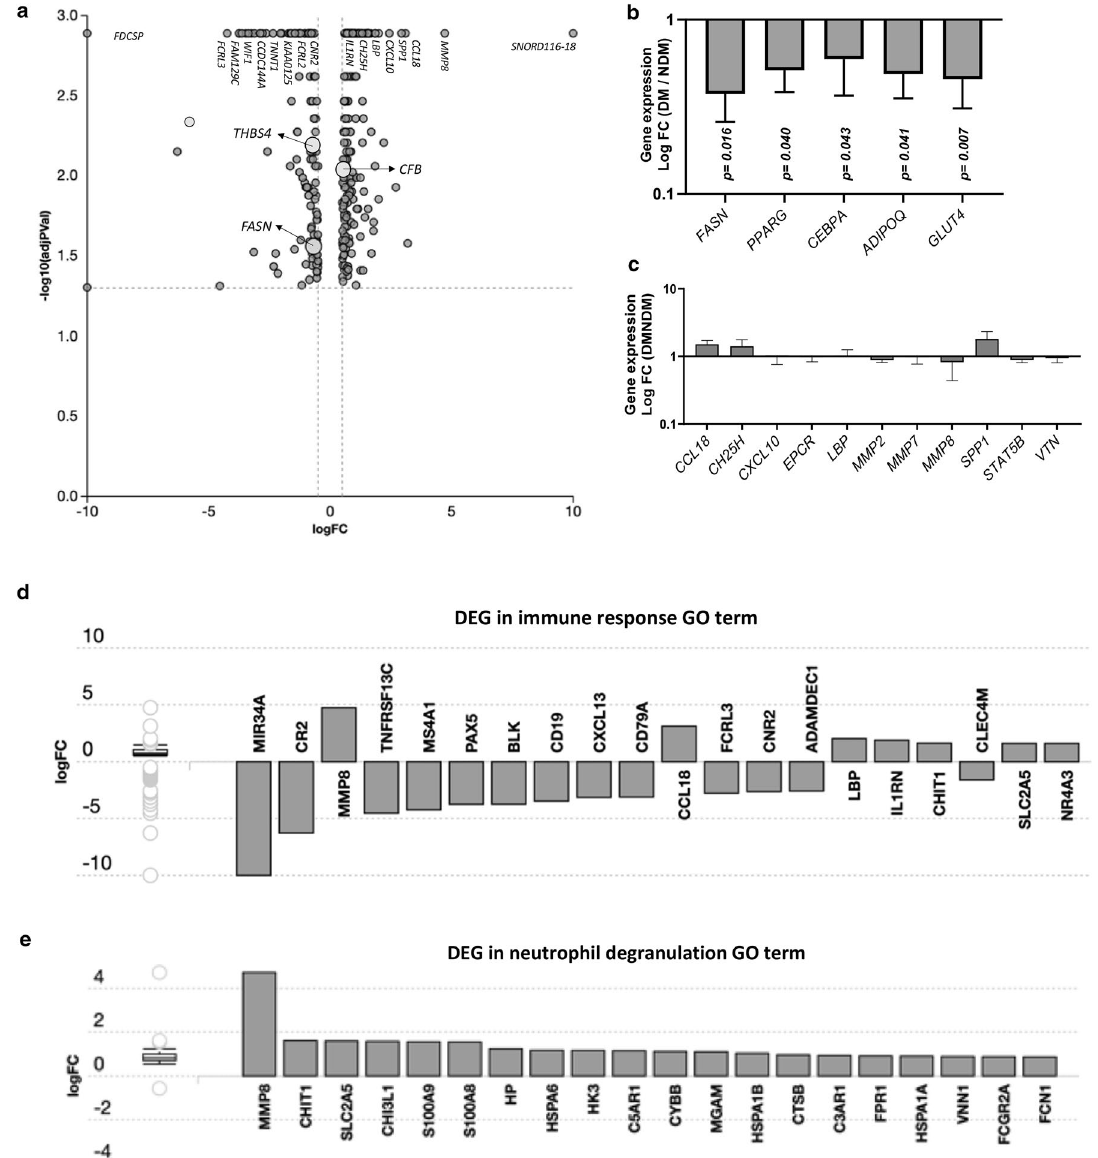
Figure 3. Differentially expressed genes and biological processes in DM and NDM VAT. ( a ) Volcano plot of gene expression in DM compared with NDM samples. All 372 significantly expressed genes (DEG) are represented in terms of their measured expression change (x-axis; log fold change) and the significance of the change (y-axis). The significance is represented as negative log (base 10) of the p-value, so that more significant genes are plotted higher on the y-axis. Genes represented on the left of logFC = 0 in the x-axis were downregulated in DM, and genes represented on the right were upregulated in DM. Dotted lines represent the thresholds used to select the DEG: 0.5 for expression change and 0.05 for significance. FASN, CFB and THBS-4 are highlighted in graph as molecules significantly regulated by DM at mRNA and protein levels. ( b ) qRT- PCR analysis of VAT for FASN gene expression and other markers of adipogenesis, lipogenesis. Results shown as log fold change in DM compared to NDM samples. ( c ) qRT-PCR analysis of VAT for inflammatory gene expression. Results shown as log fold change in DM compared to NDM samples, all p > 0.050. ( d , e ) Top 20 DEG genes in top scoring biological processes in obese human VAT. DEG are ranked based on absolute value of log fold change. The box and whisker plot on left summarizes the distribution of all DEG in this GO term. The box represents 1st quartile, median and 3rd quartile, while outliers are represented by circles. Bars bellow logFC = 0 represent genes downregulated in DM compared to NDM samples, while bars above logFC = 0 represent genes upregulated in DM compared to NDM